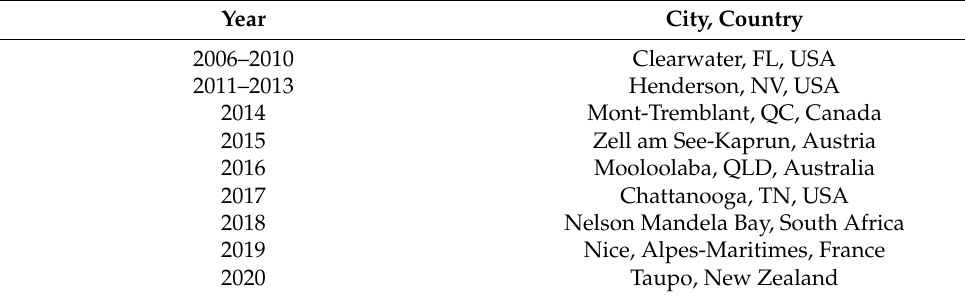
Table 2. Locations of Ironman ® 70.3 World Championships.